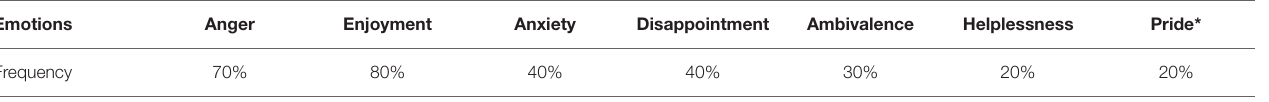
TABLE 2 | Discrete emotions experienced by Chinese EFL teachers. Emotions Anger